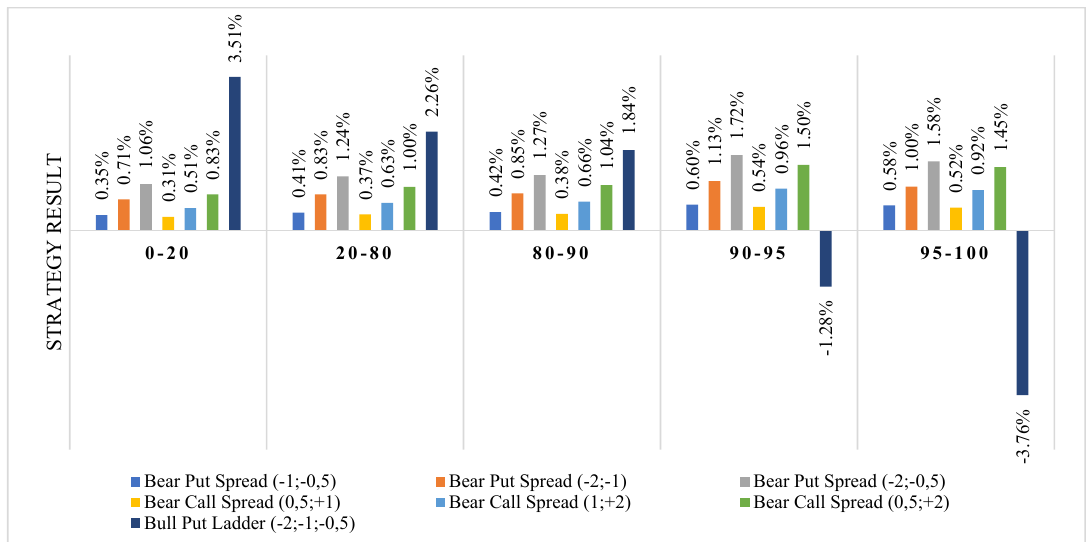
Figure 8. Bear put spread, bear call spread, and bull put ladder results for declines of WTI crude oil prices ranging from 5% to 10%.